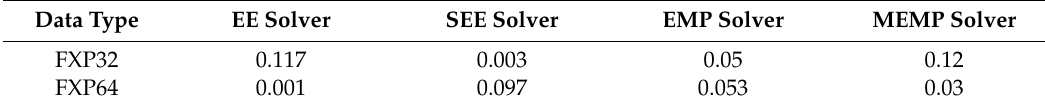
Table 5. The largest interspike interval errors between FXP and DBL solvers, ms.